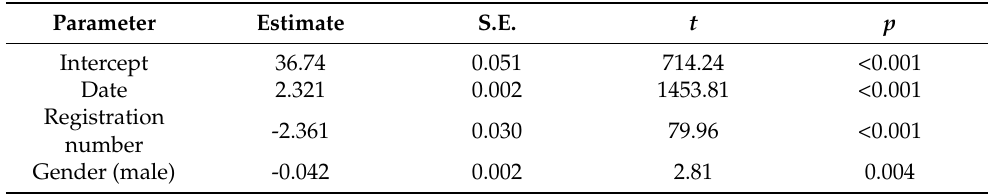
Table 4. A linear mixed model of the age of participants at parkrun events in Scotland. Event venue was included as a random effect.